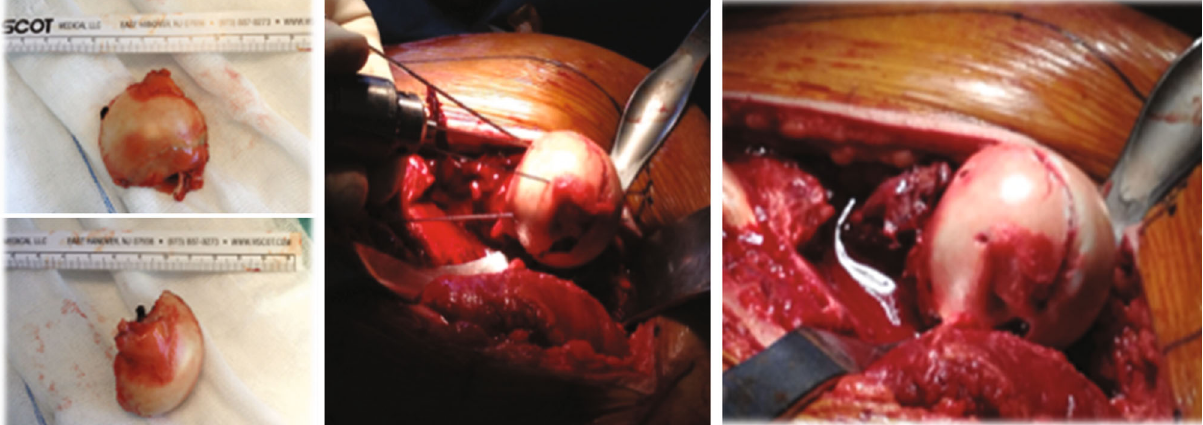
Figure 3: Femoral head fragment and its rigid fi xation with 3 subchondral cannulated